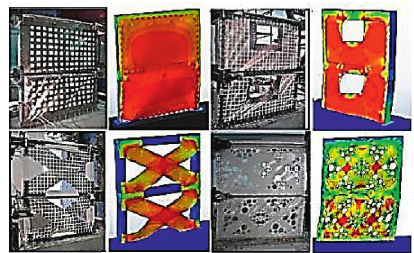
Figure 8: Cracks developed in a reinforced concrete panel with a SSW